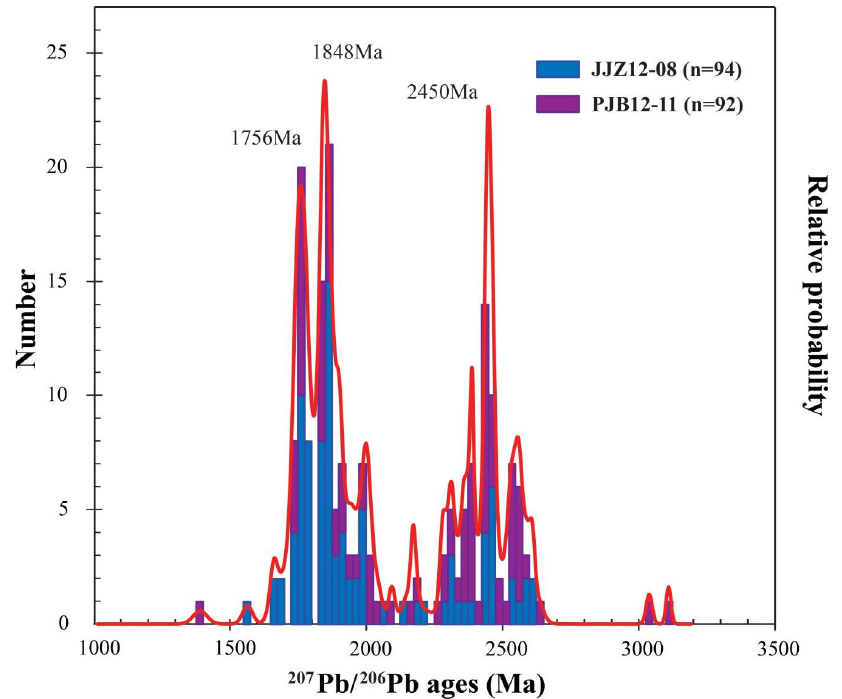
Figure 7. Relative probability of the detrital zircon grains’ U-Pb ages.